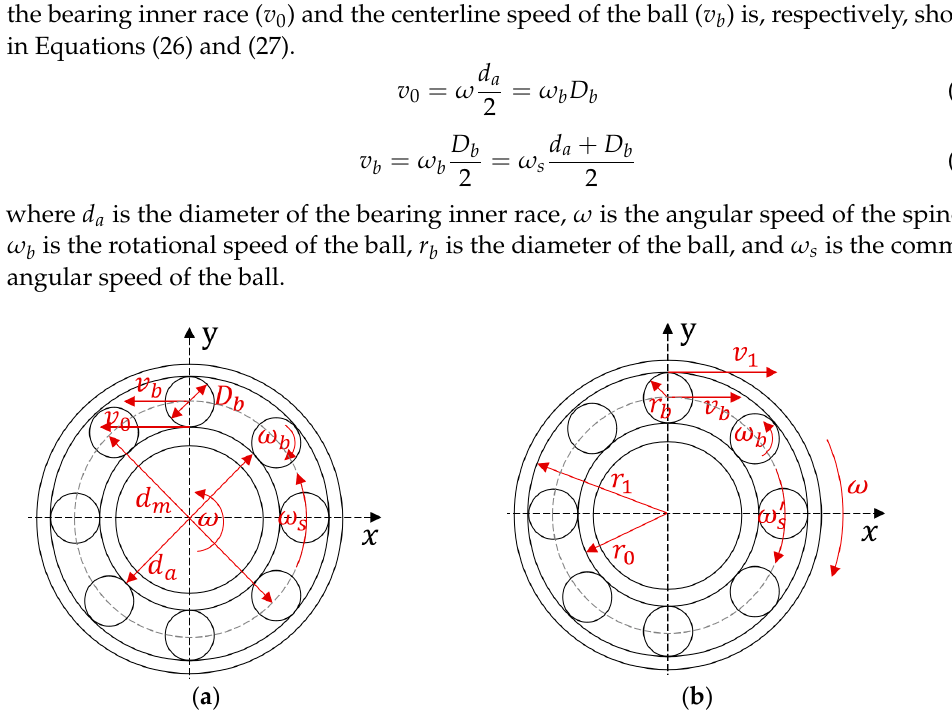
Figure 9. Calculation relation diagram of fatigue times of bearing balls. ( a ) Bearing motion relation- ship in machine tool coordinates. ( b ) Bearing motion relationship in RAT coordinate system.